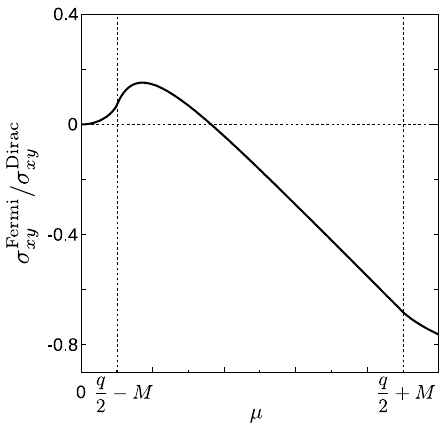
(cid:16) σ Fermi . Figure 3. Density dependence of (cid:2888)(cid:2887)(cid:2888)(cid:2907)